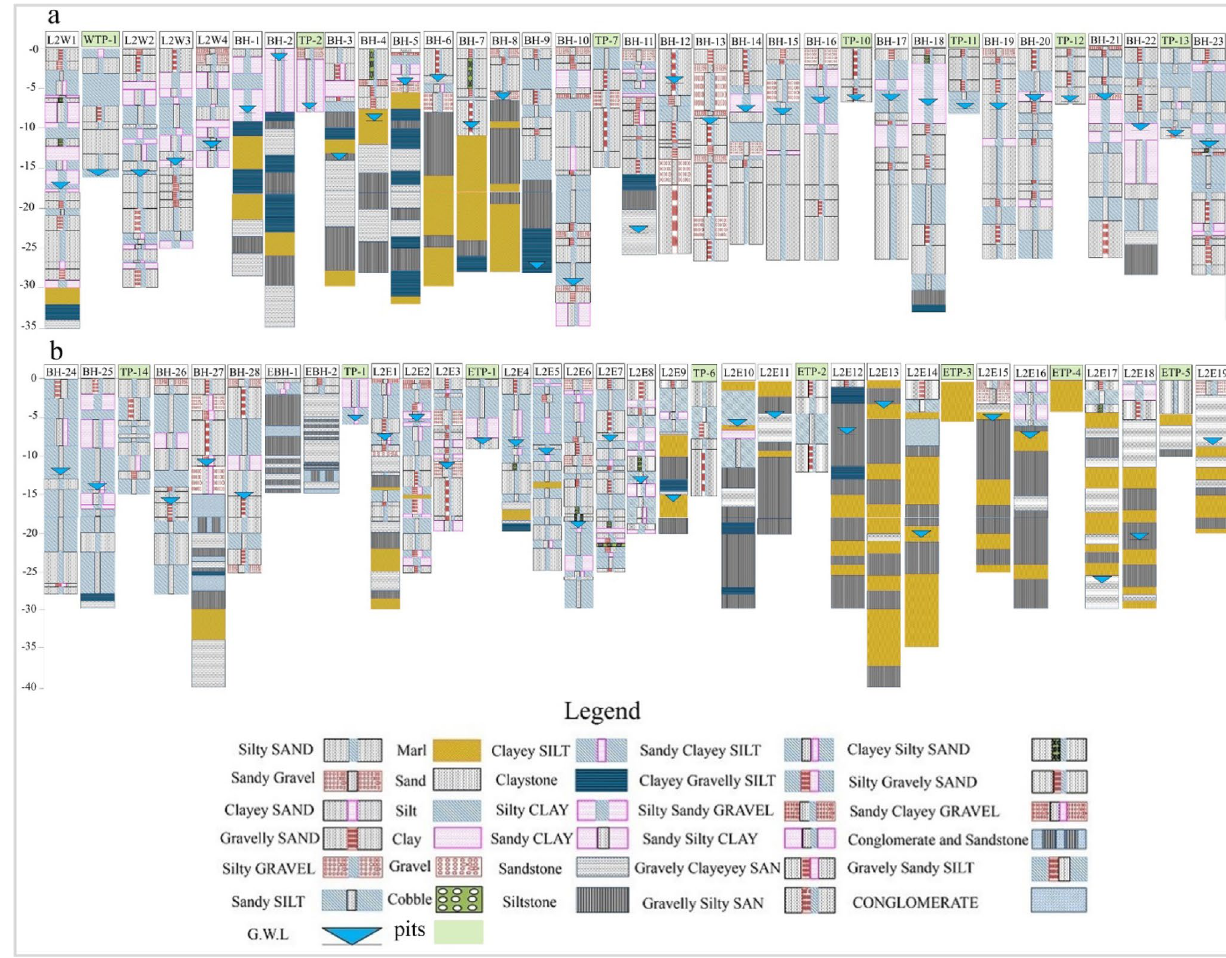
Fig. 6 Logs of drilled pits and boreholes (a and b) along the route of line 2 of Tabriz metro (Authors)